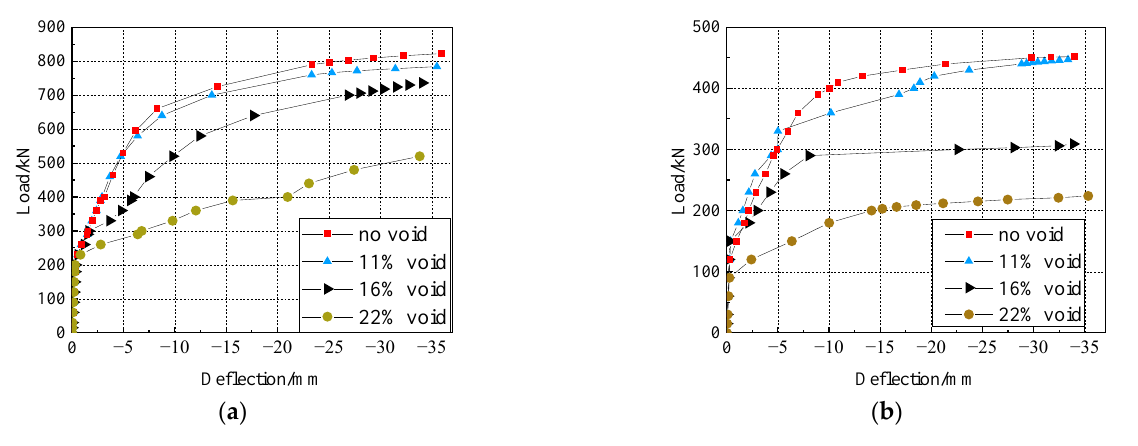
Figure 13. Effect of hollow ratio. ( a ) Distribution load. ( b ) Point load.